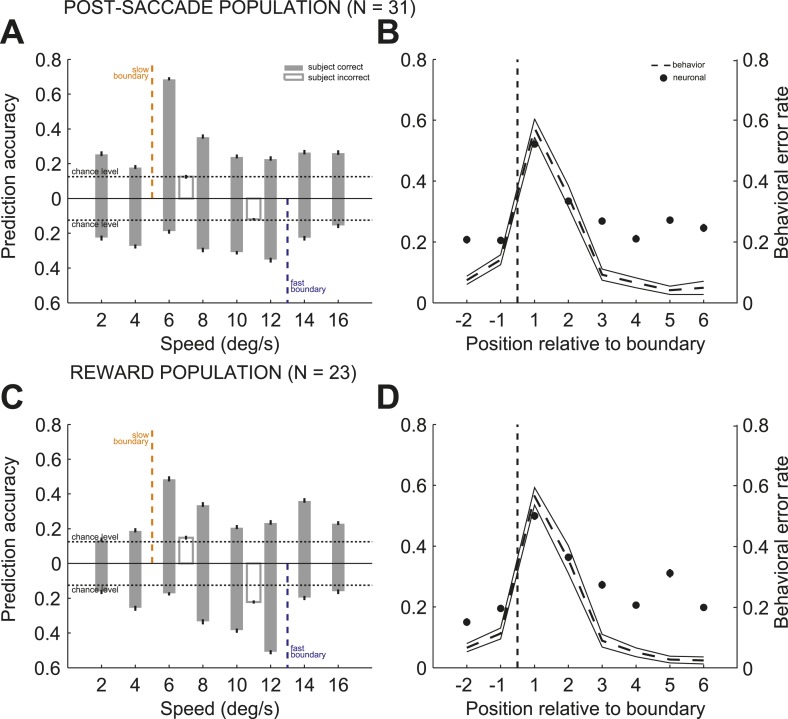
Population read out of speed and boundary position.(A and C) Proportion of correct estimates for each stimulus speed separately for slow (upper bars) and fast (lower bars) boundary positions for post-saccade (A) and reward (C) populations for correct only (gray) and incorrect (open) trials. (B and D) Average prediction accuracy for speed (black circles) and behavioral error rate (mean ± SEM, dashed and solid lines) as a function of stimulus' position to the boundary (dashed line) for each neuronal population. The prediction accuracy for the most extreme stimuli (speeds 2, 4, 14, and 16) deviated from the behavioral error rate function, possibly due to a greater perceptual uncertainty, about the identity of the stimulus or boundary cue, compared to the intermediate stimuli.